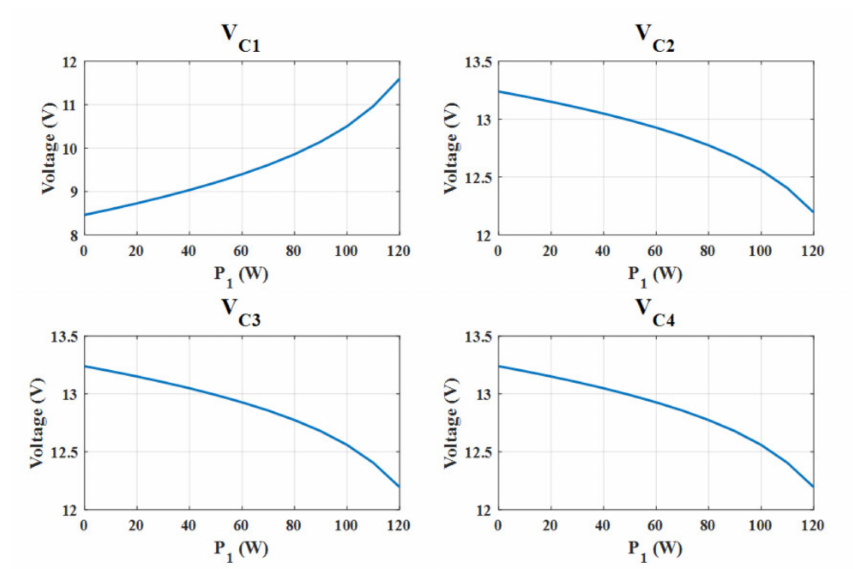
Figure 15. Voltage changes of the boost converters’ output capacitor connected to fuel cell stacks in closed-loop by changing the injected power of the first stack while the other stacks inject the nominal power of 126 W.